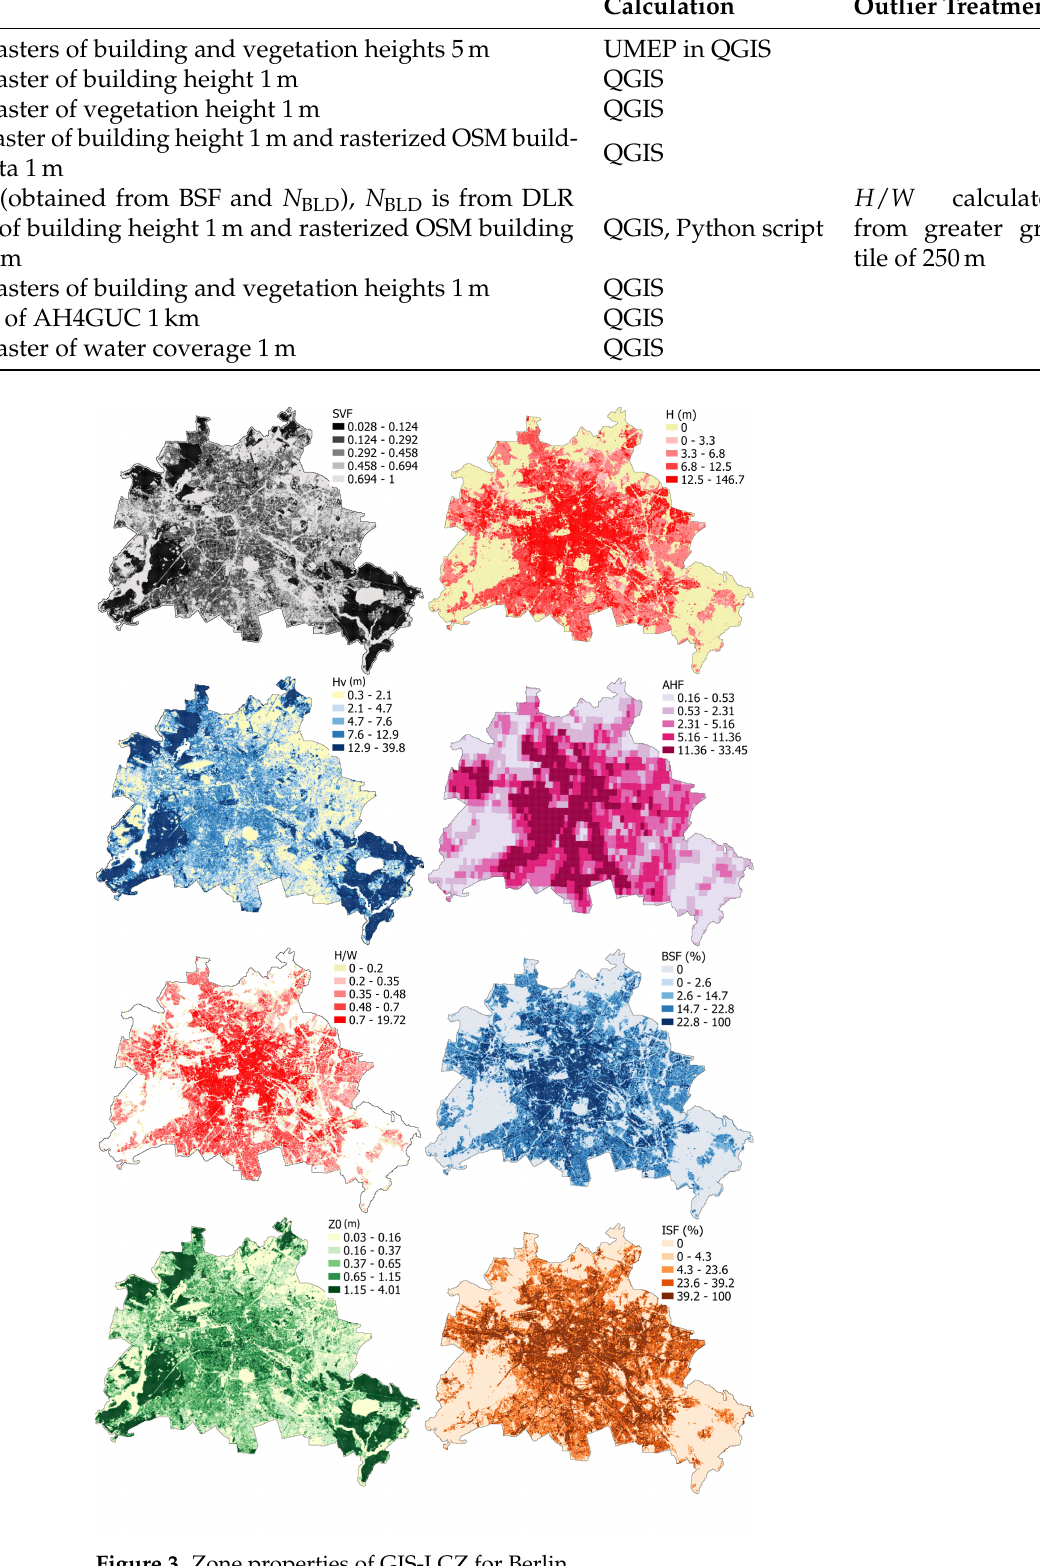
Figure 3. Zone properties of GIS-LCZ for